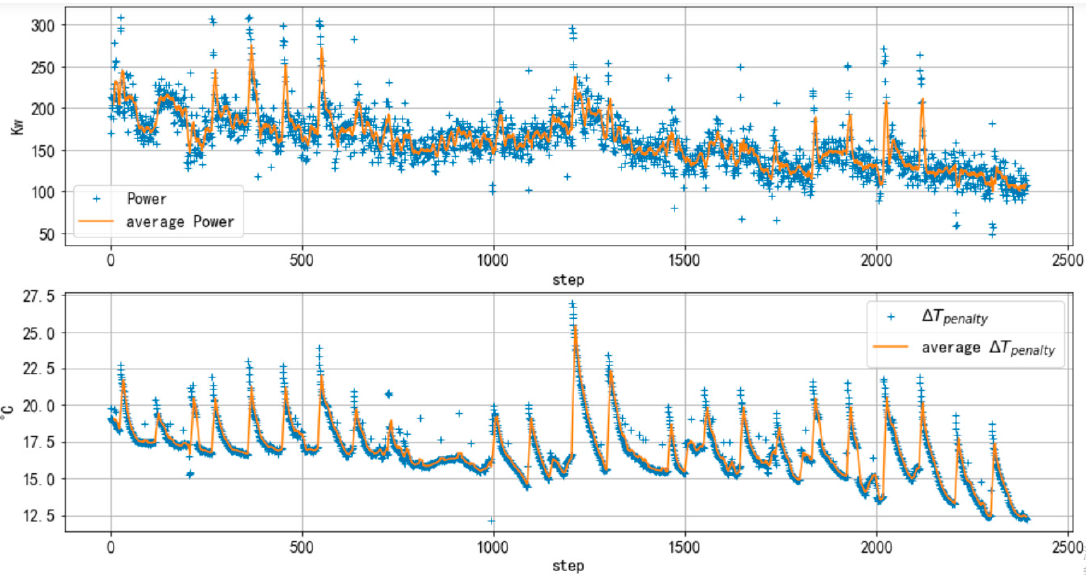
Figure 8. Power consumption and indoor temperature penalty trends of proposed RL algorithm.